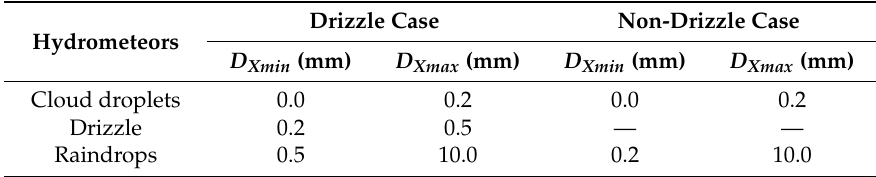
Table 1. Minimum and maximum values for various categories of liquid